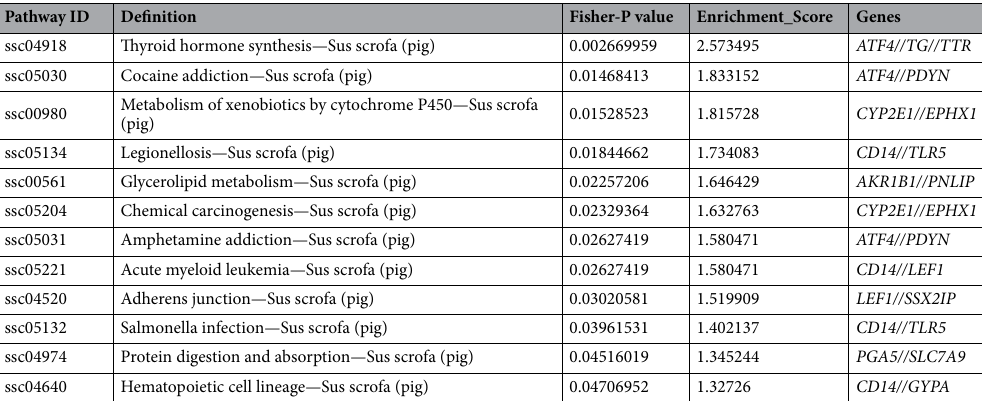
Table 10. The pathways with down-regulated gene enrichment